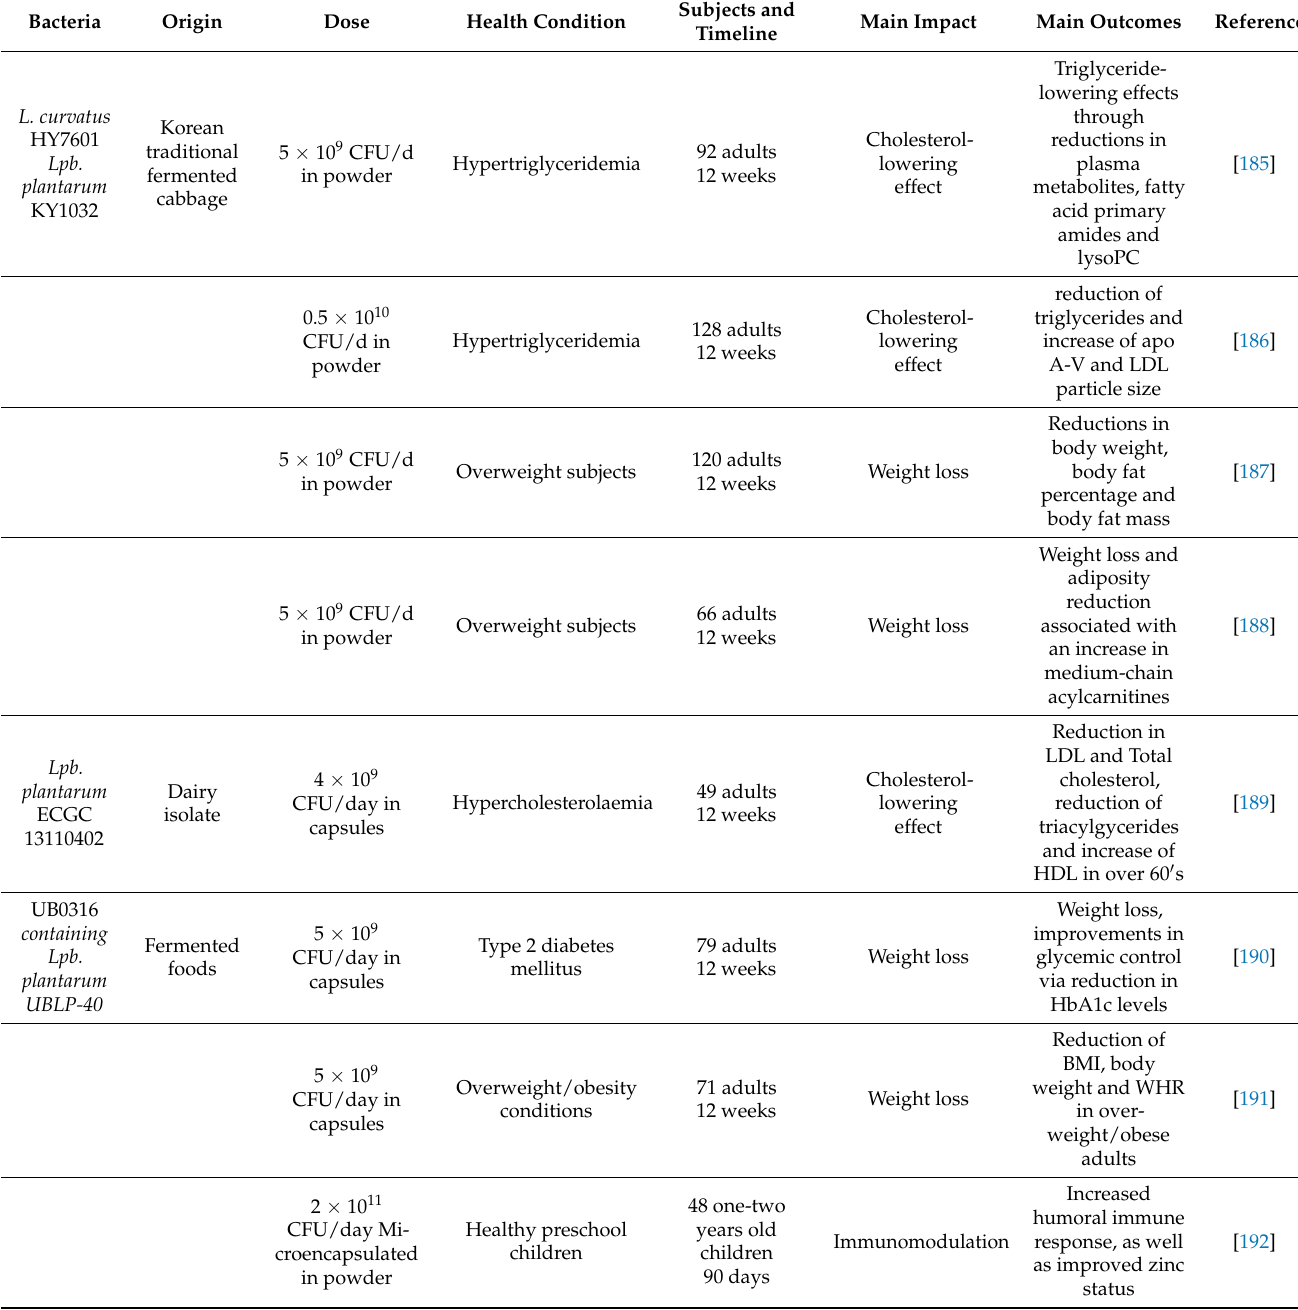
Table 2. Clinical studies of food-associated Lpb. plantarum strains showing efficacy for treatment of several disorders.